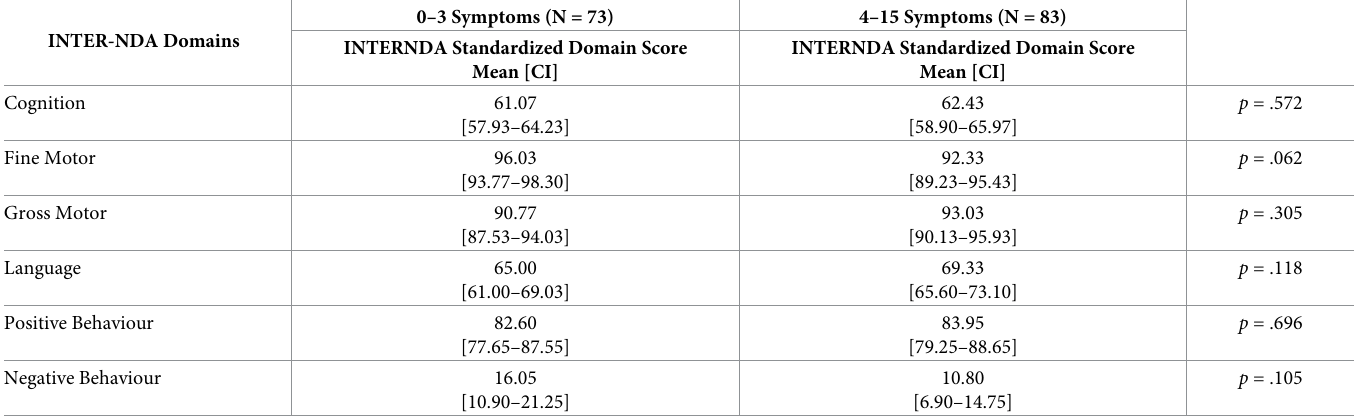
Table 6. Mean differences on standardized INTER-NDA domain scores between children born to mothers with fewer (i.e., 0–3) versus more (i.e., 4–15) symptoms during pregnancy. INTER-NDA